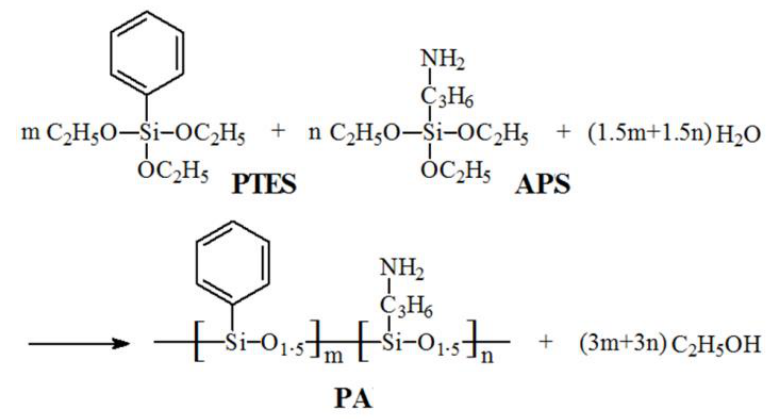
Figure 1. Synthesis of PA.